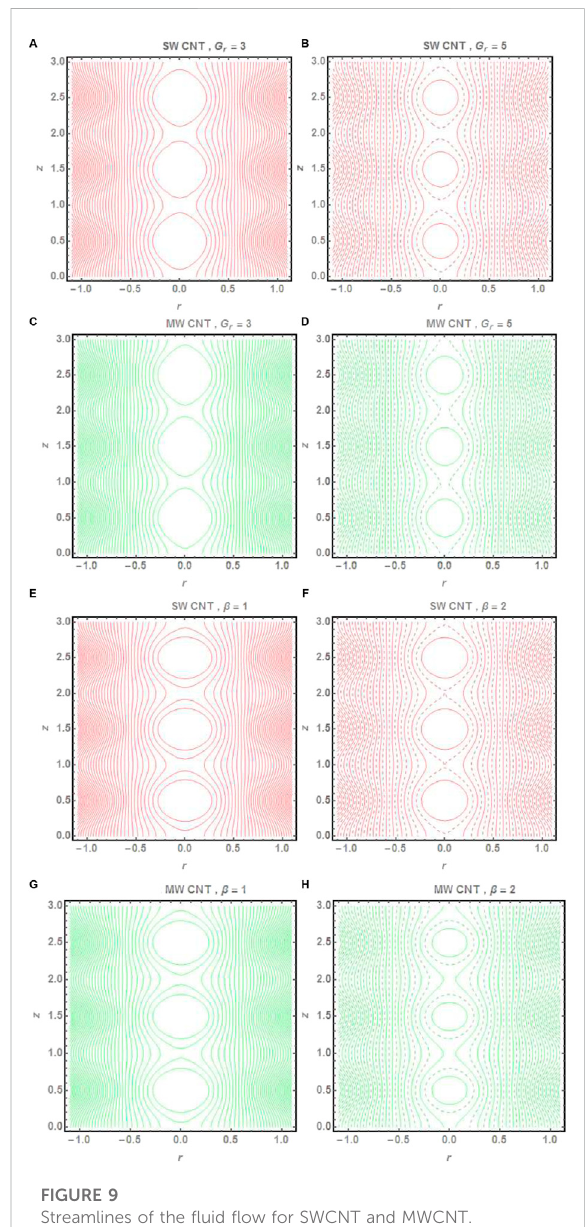
FIGURE 9 Streamlines of the fl uid fl ow for SWCNT and